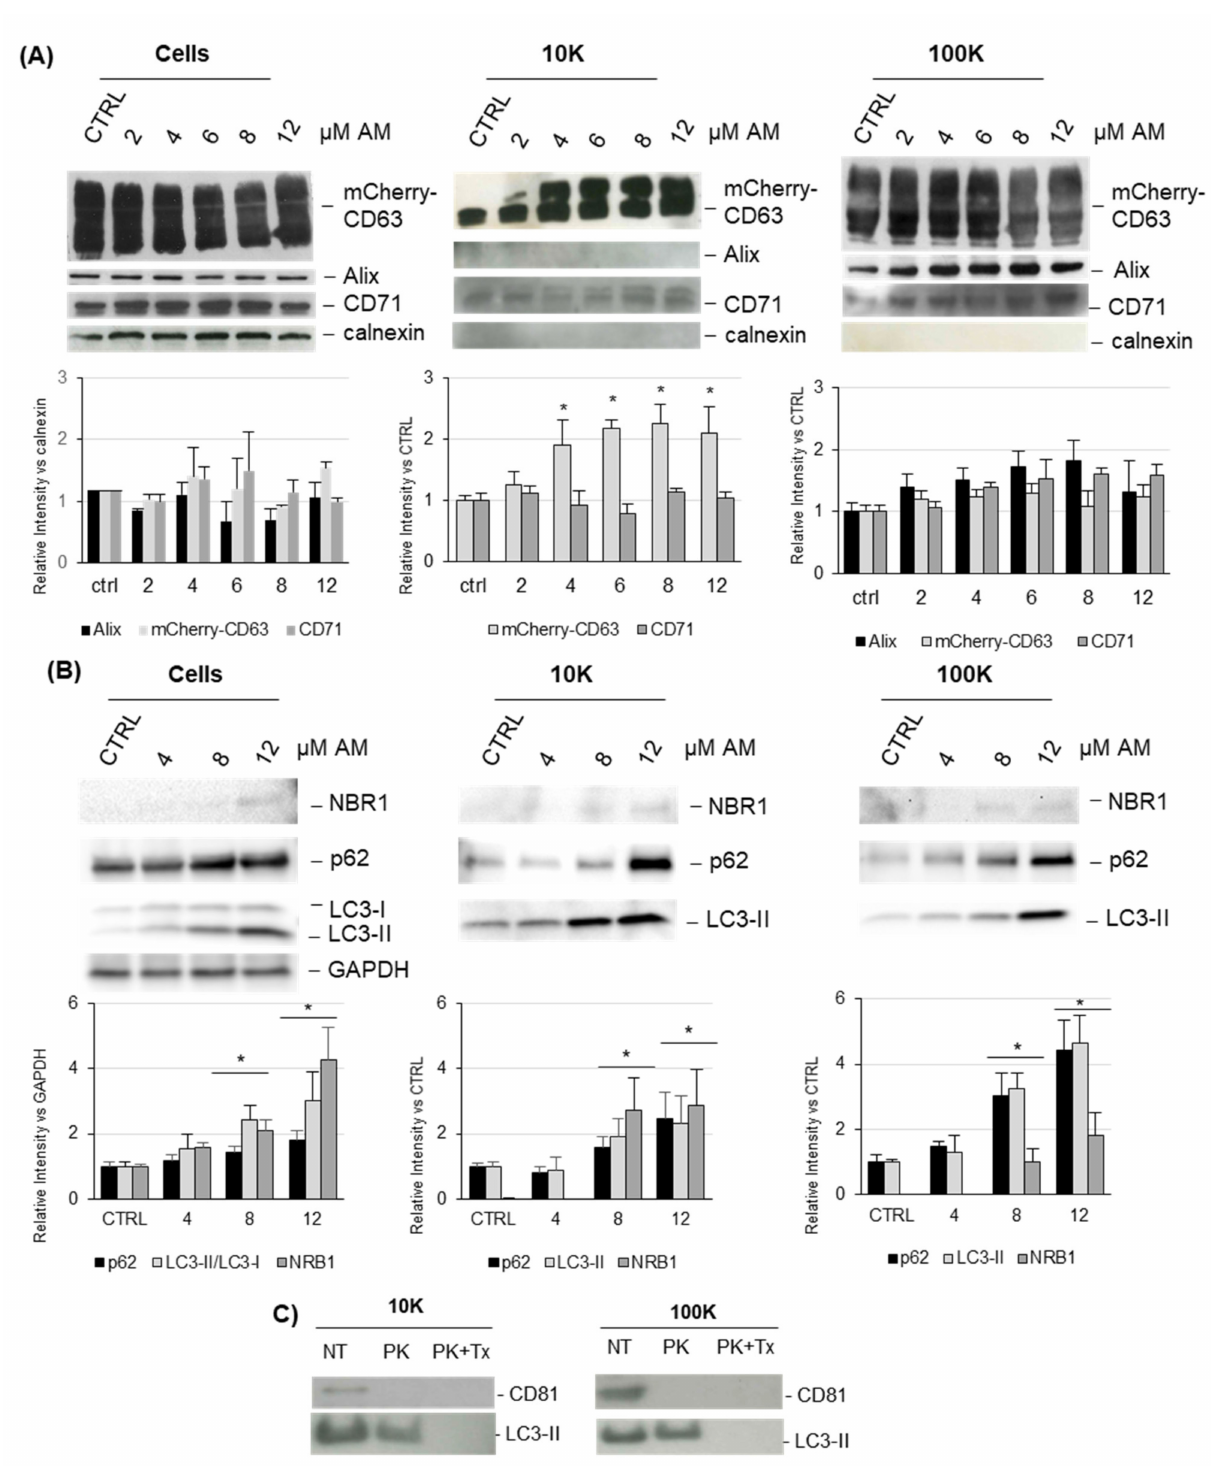
Figure 6. Characterization of EVs released from HEK-mCherry-CD63 upon AM treatment . Cell extracts (30 µ g) and EV preparations (3 µ g) were separated by SDS-PAGE, electrotransferred, and then probed with the indicated markers (Panel ( A ) and with autophagy markers (Panel ( B )). The densitometric analysis of results is reported below. In cell extracts, bars represent the ratio between the intensity of the band signal and calnexin (Panel ( A ), left ) or GAPDH (Panel ( B ), left ). In EVs, bars represent the ratio between the intensity of the band signal of AM-treated sample and vehicle-treated sample as control (set 1). When the signal was not detected in the vehicle-treated sample, the lowest intensity band detected was set at 1. Bars are reported as relative intensity. Results represent the mean ± SD of three independent experiments (* p <